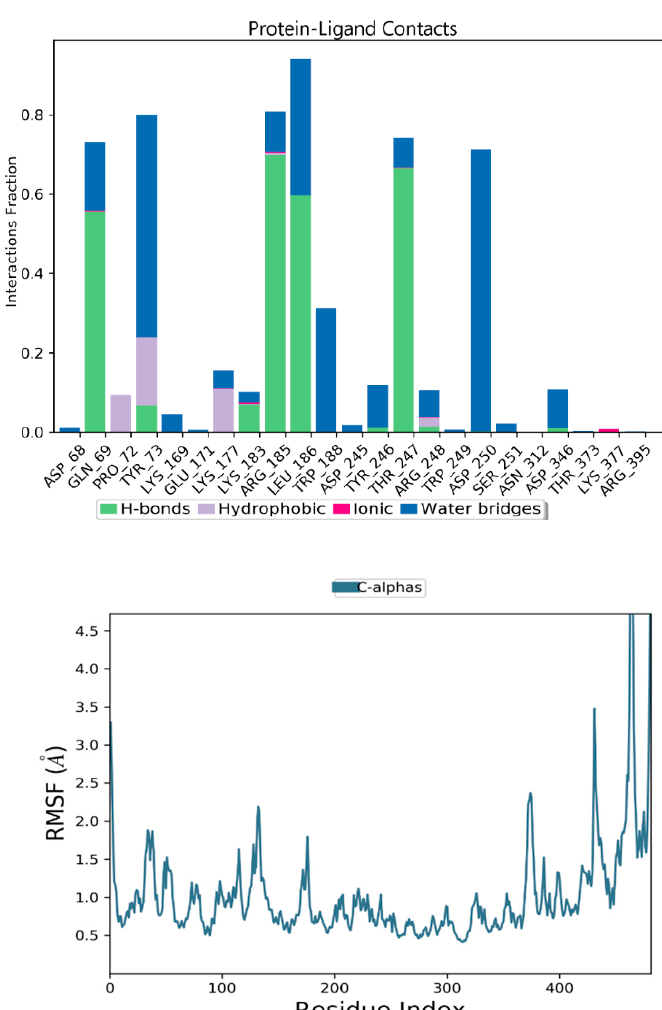
Figure 10. ( A ) MDSs trajectory output revealing the root-mean-square deviation (RMSD) plot of CID-44396095 bound to MNV RdRp; ( B ) Binding interaction of CID-44396095 -MNV RdRp after MDSs; ( C ) Ligplot representing interaction of CID-44396095 with different residues of MNV RdRp throughout the simulation trajectory ( D ) Graphical depiction of root-mean-square fluctuation (RMSF) of CID-44396095 with different residues of MNV RdRp